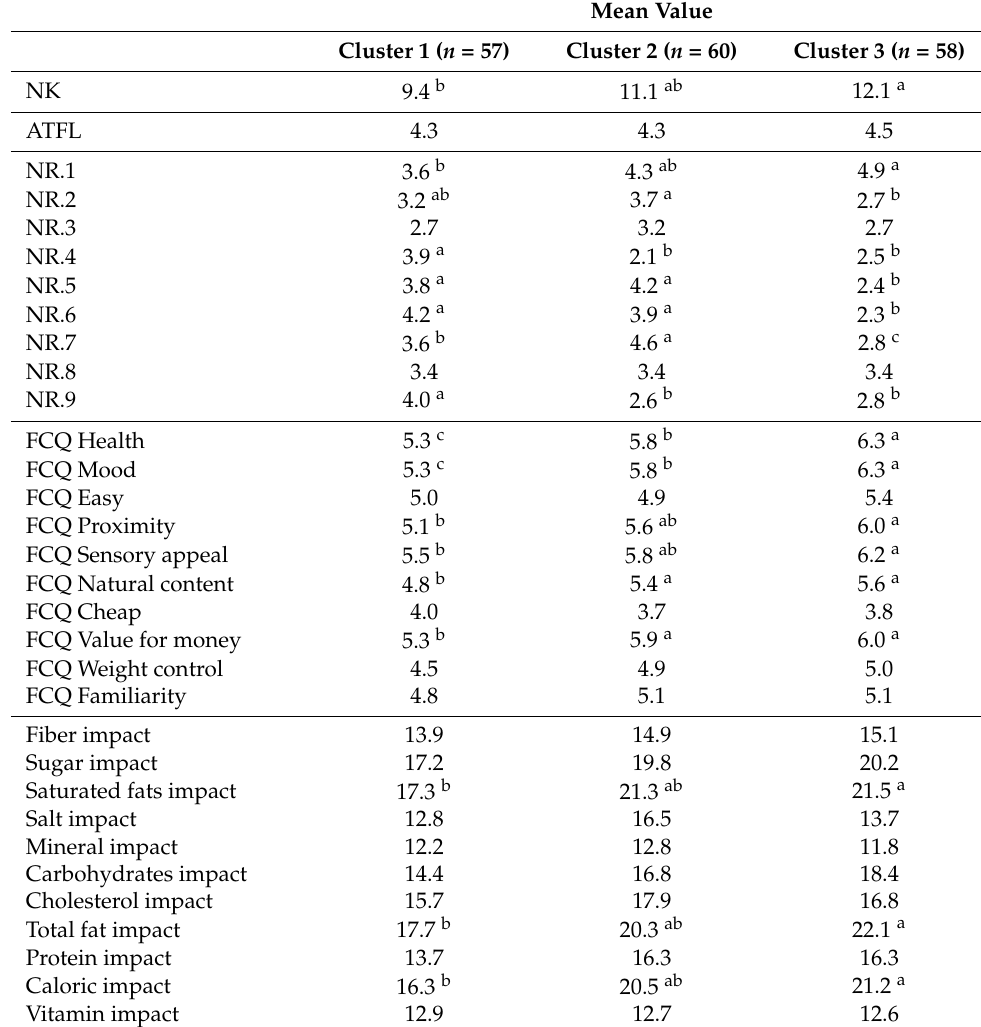
Table 6. Mean values per cluster of the different items or constructs assessed in the questionnaire for the participants who did not follow a